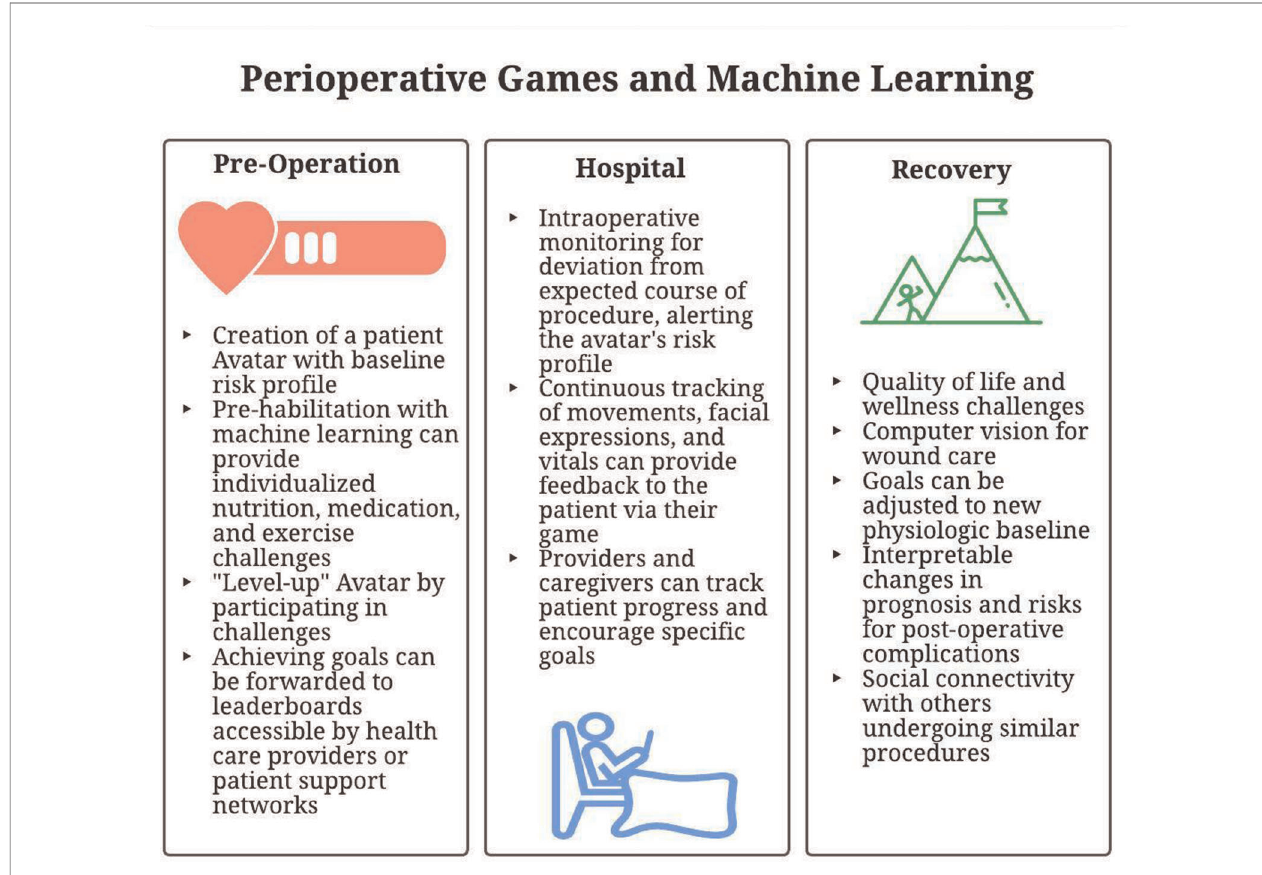
FIGURE 1 | A summary of the potential application